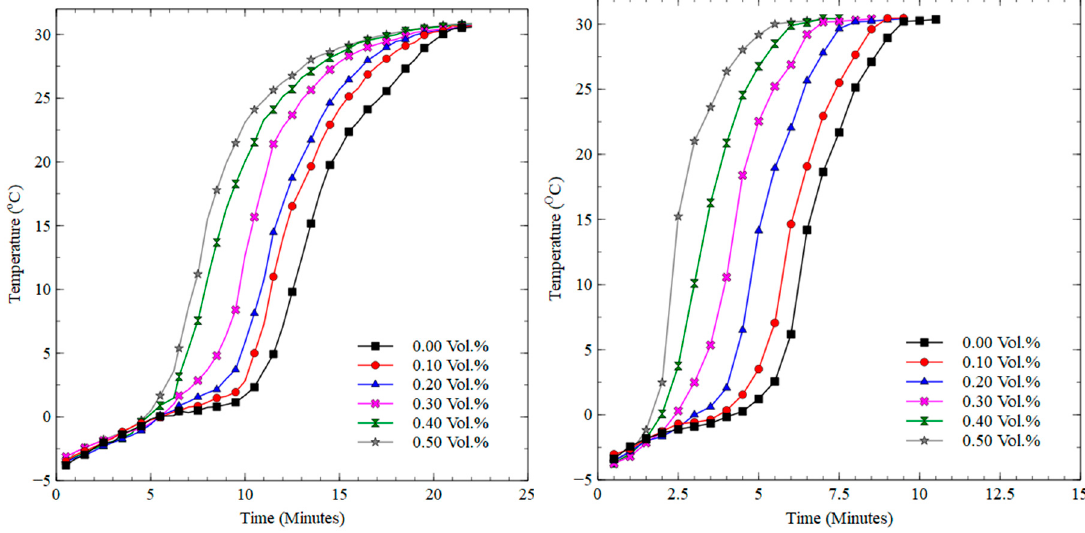
Figure 6. Melting curves from − 3 °C to 30 °C with a bath temperature at 31 °C and 36 °C.